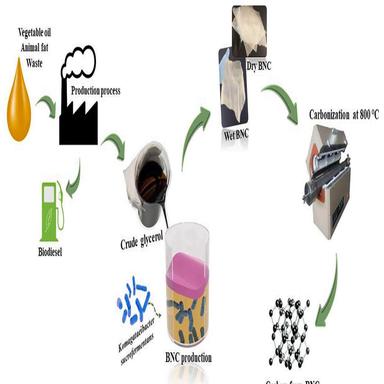
Schematic representation of the nanostructured carbon materials from BNC produced in a crude glycerol medium.